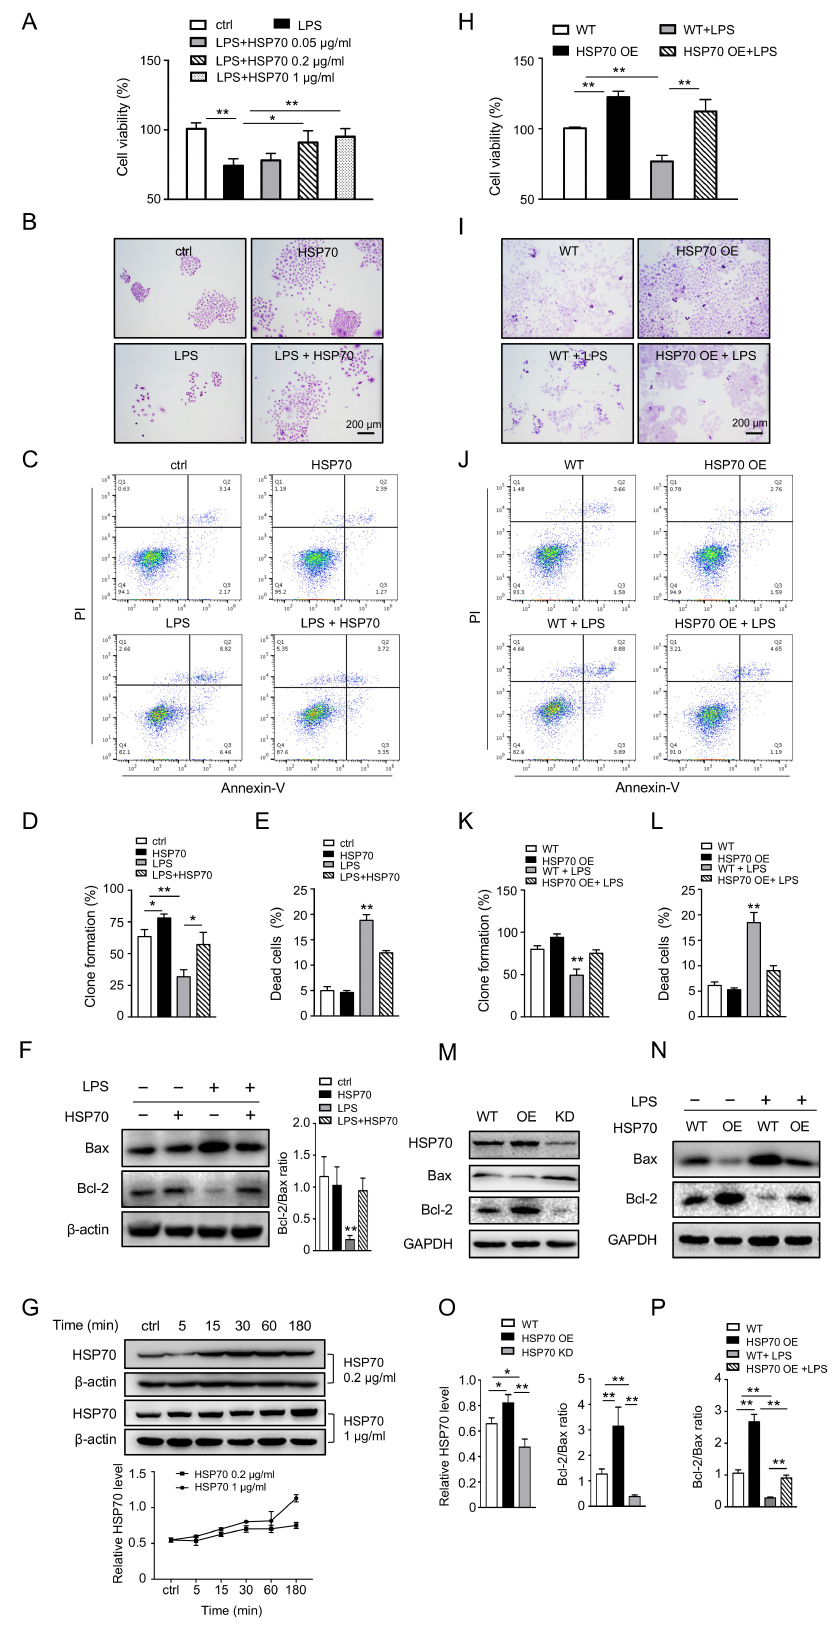
Figure 3. Effects of HSP70 on apoptosis in alveolar epithelial cells. Human alveolar epithelial A549 cells were cultured and treated with LPS (4 µ g/mL) and HSP70 (0.2 µ g/mL was used unless